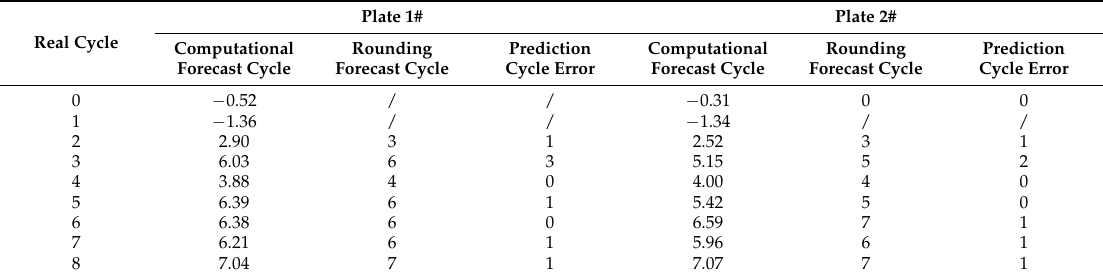
Table 2. Prediction results of improved degradation kinetics model.